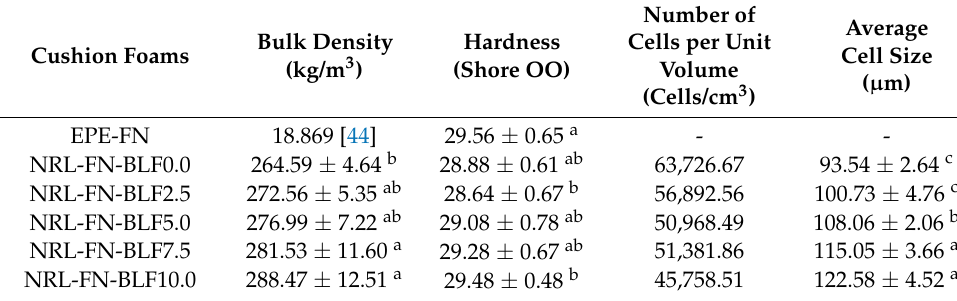
Table 2. Foam properties of EPE-FN and NRL-FN-BLFs.